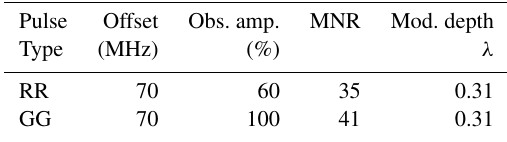
Table 1. The rectangular and Gaussian pulses with the best perfor-